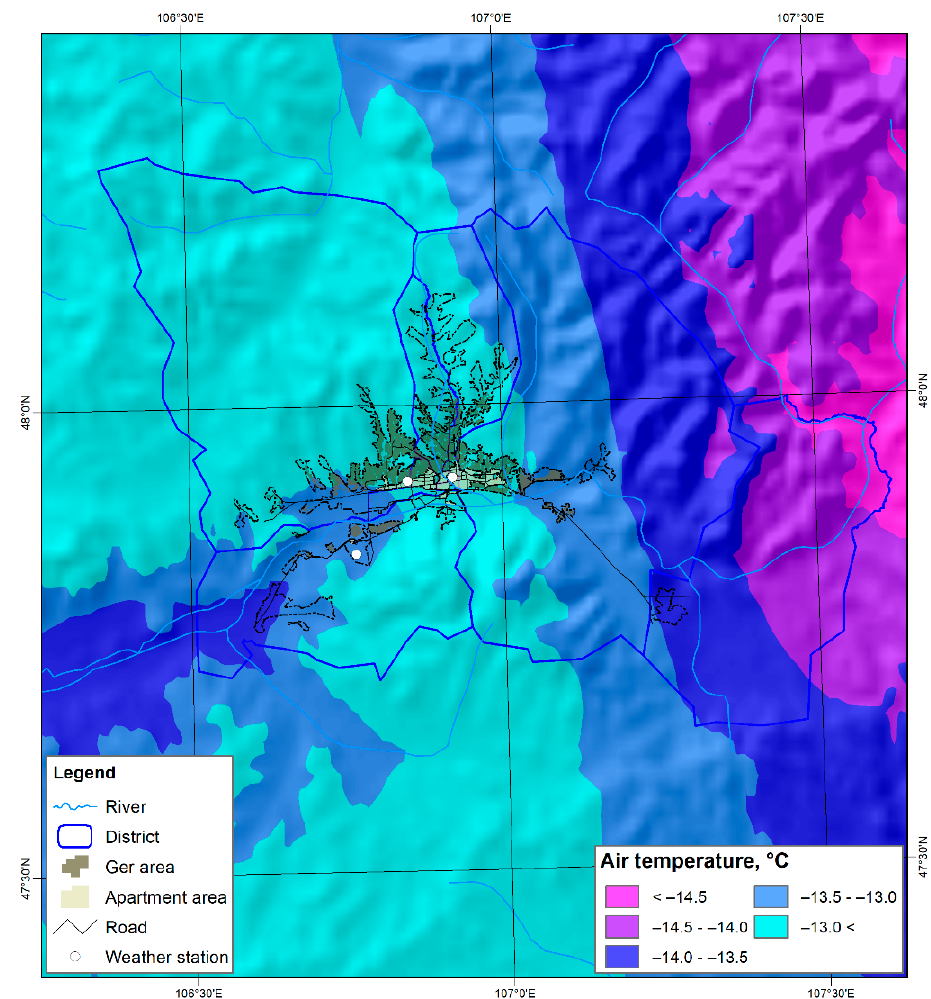
Figure 5. Spatial distribution of the average air temperature of the cold season (October to March) around Ulaanbaatar city (1991 to 2020).